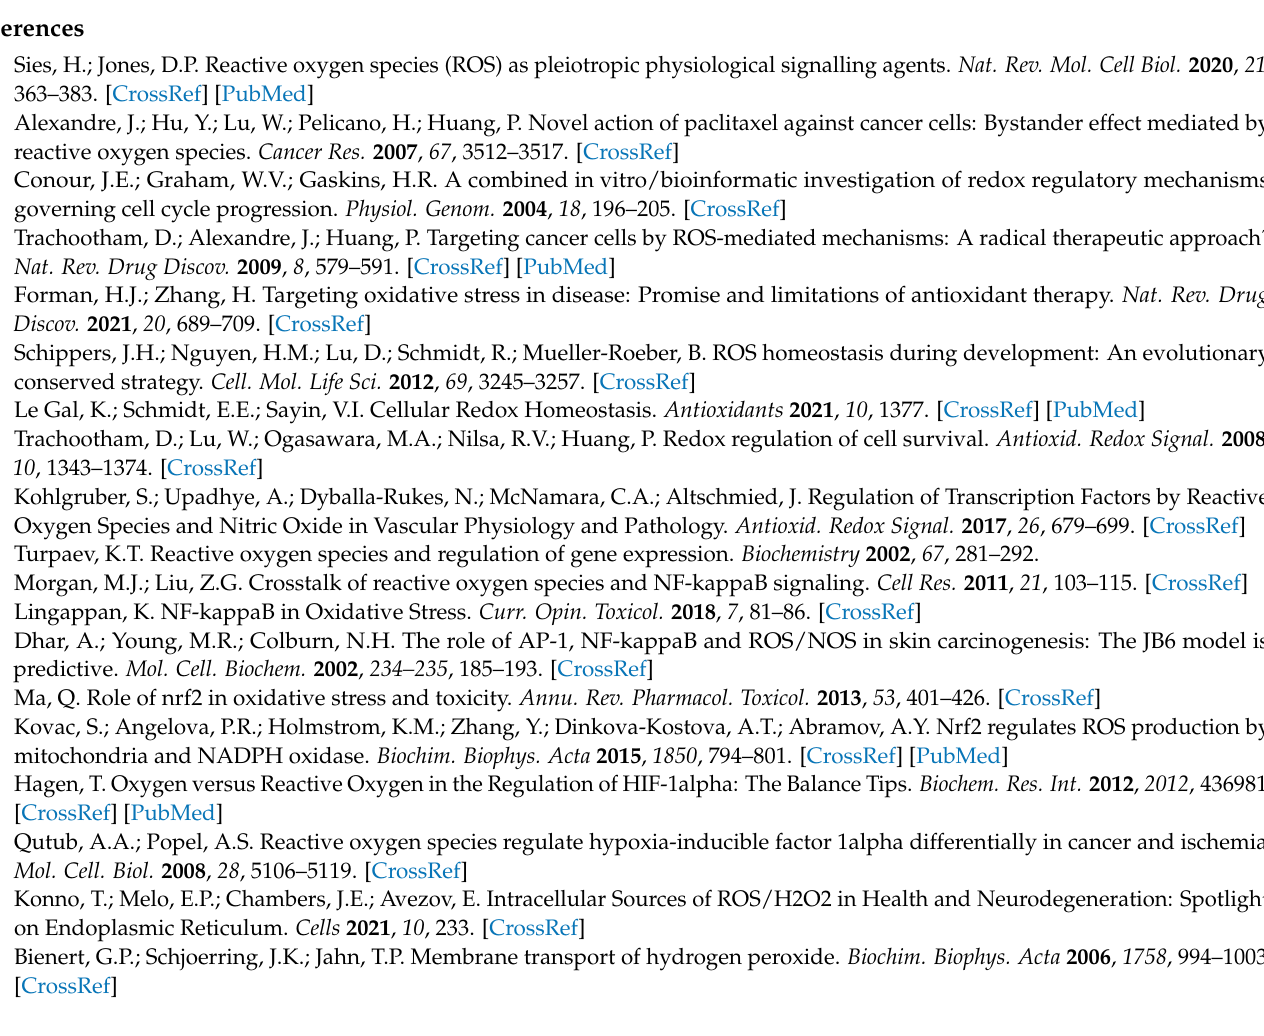
H 2 O 2 . Expression of enriched genes in “Transcriptional misregulation in cancer” pathway in HPNE (left) and PANC 1 cells (right) treated with sub toxic concentrations of H 2 O 2 (0.3 mM for HPNE and 1.0 mM for PANC 1 cells for 12 h) was measured by transcriptome sequence (A) or by qRT PCR (B). Data are means ± SEM of three separate experiments; two tailed unpaired t test for B; *, p < 0.05. Figure S4. Expression of genes associated with “Transcriptional misregulation in cancer” pathway in HPNE and PANC 1 cells treated with H 2 O 2 . Quantitative RT PCR measured Transcriptional misregulation in cancer signal associated genes in HPNE (A) and PANC 1 (B) cells treated with H 2 O 2 (HPNE: 0.3 mM; PANC 1: 1.0 mM) for 1 h or 12 h as indicated. Data are means ± SEM of three separate experiments; two tailed unpaired t test; *, p <